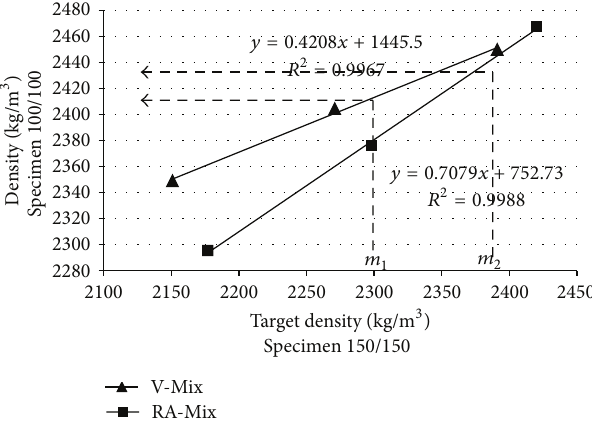
Figure 10: Relationships of the density of the cores (120/100) and the target compacted density of specimen